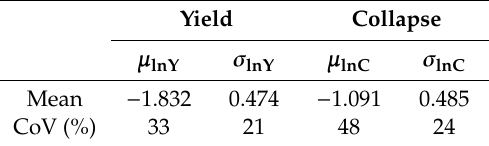
Table 1. Mean and coe ffi cient of variation (CoV) of parameters of reinforced concrete (RC) fragility curves.